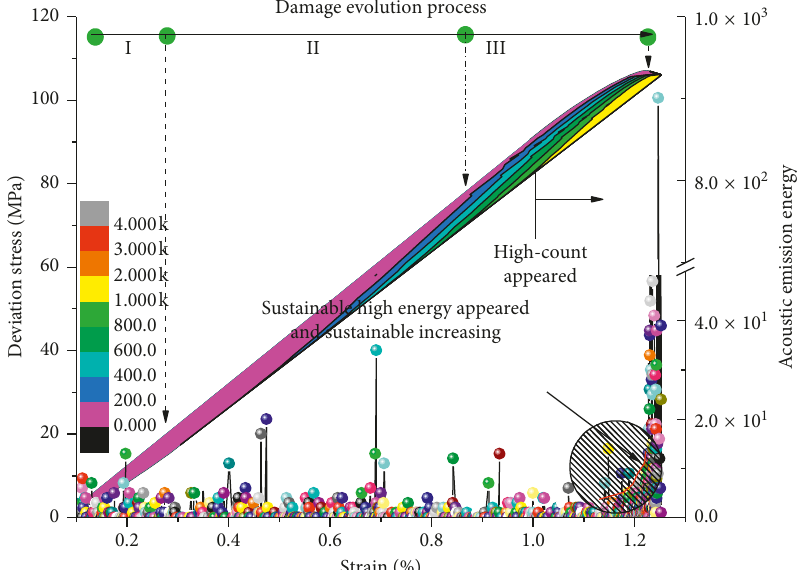
Figure 10: Partial stress-strain acoustic emission counting: acoustic emission energy damage evolution process by sz-22.